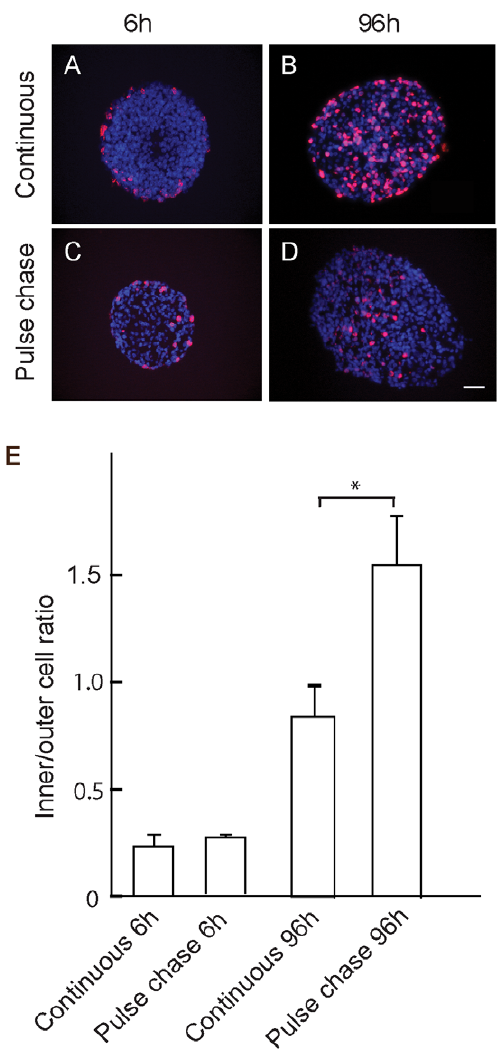
Figure 1. Cell proliferation in mouse neurospheres after continuous labeling and pulse-chase with BrdU. A, B: Continuous labelling with 10 m M BrdU after 6 h (A) and 96 h (B) culture. C, D: Labelling after 1 h pulse of 10 m M BrdU, neurospheres immediately after the pulse (C), and 96 h after chase in absence of BrdU (D). Images show immunostaining for BrdU of sections taken through the equatorial region of the neurospheres, counterstained with DAPI. E: Ratio of BrdU stained nuclei in the inner 50%/outer 50% of the area of the sections. Values are means 6 SEM (n . 5) from 2 independent experiments. *p , 0.01. Scale bar=25 m